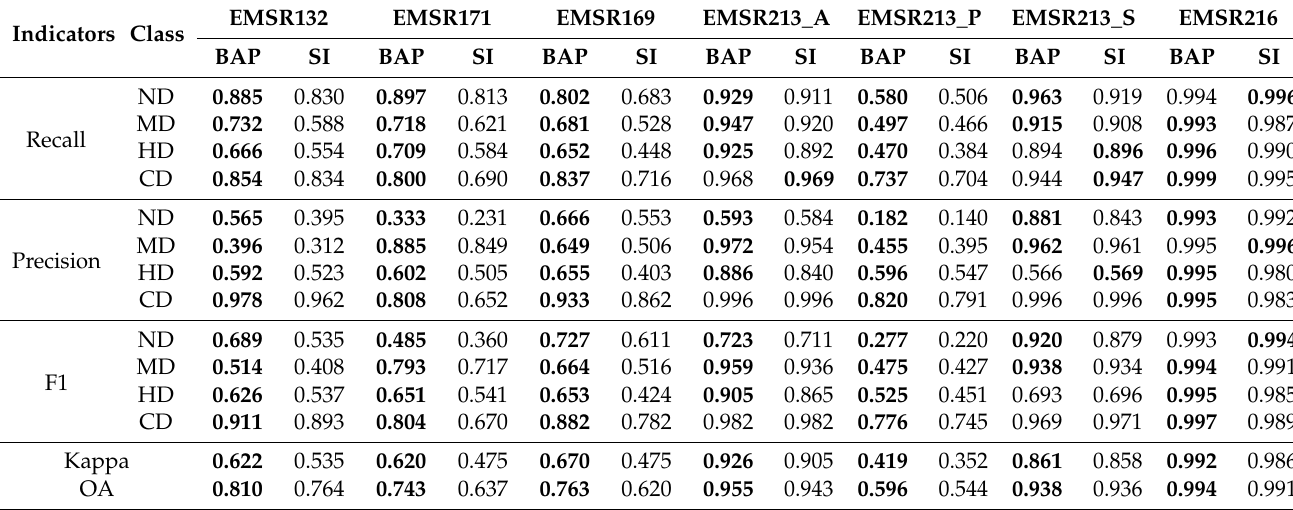
Table 3. Performance comparison of fire severity classifications using BAP and Spectral Indices (SI) methods for each fire in the European Mediterranean region. ND: Negligible to Slight Damage; MD: Moderately Damaged; HD: Highly Damaged; CD: Completely